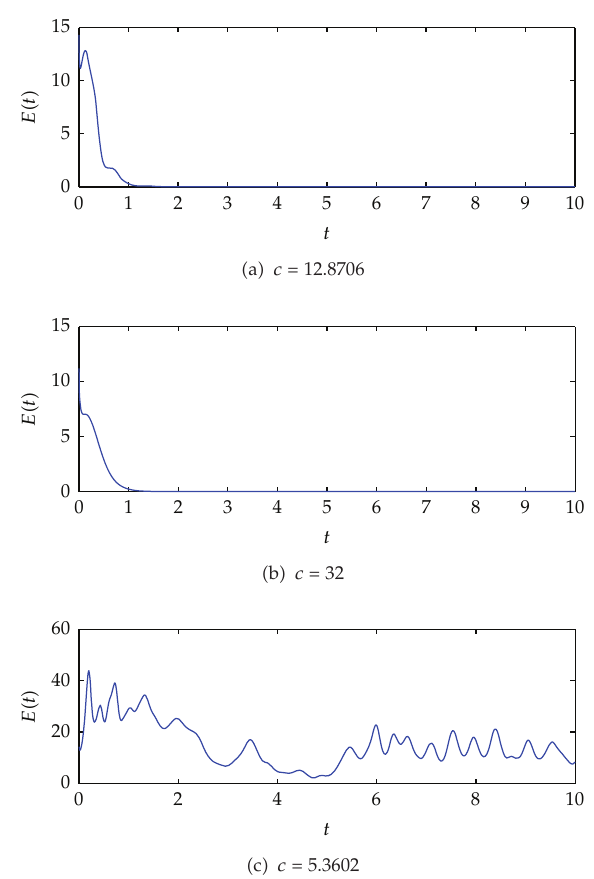
Figure 9: The cluster synchronization error under di ff erent coupling